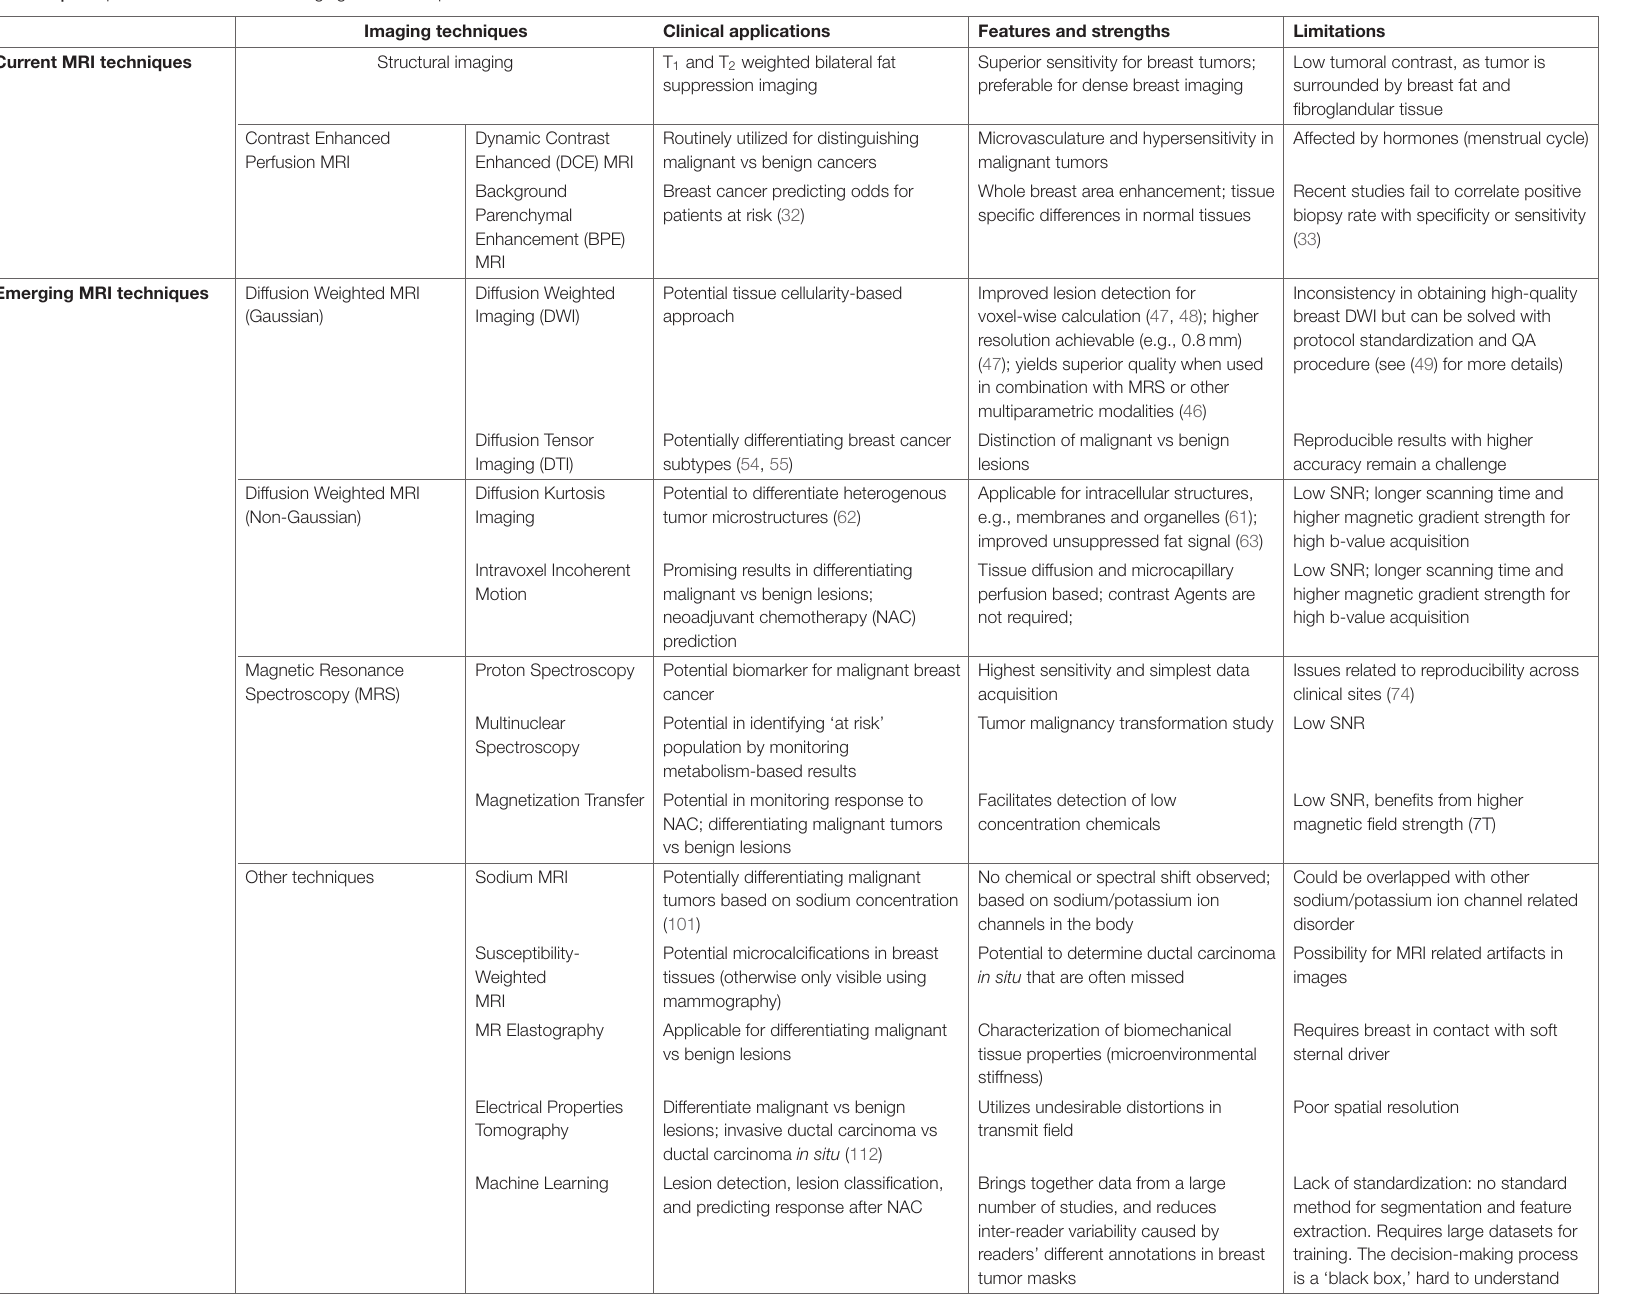
TABLE 1 | Comparison of current and emerging MRI